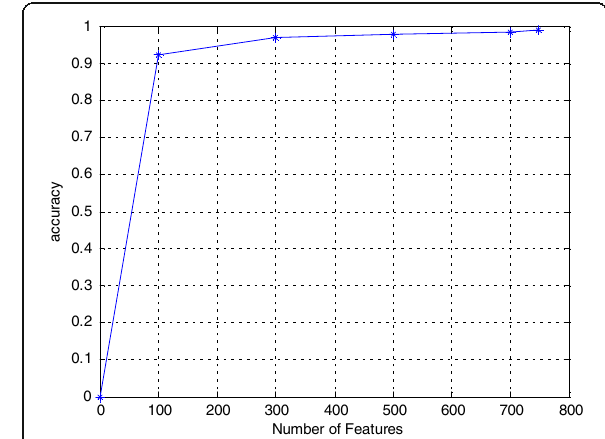
Fig. 5 Recognition rates with different number of texture features